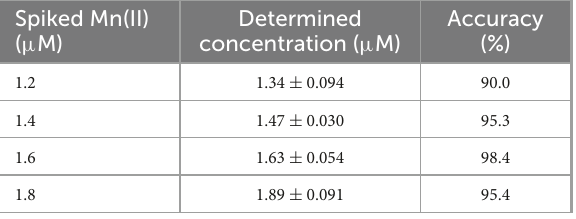
TABLE 3 The quantification of Mn(II) in mancozeb spiked water samples. Spiked mancozeb ( µ